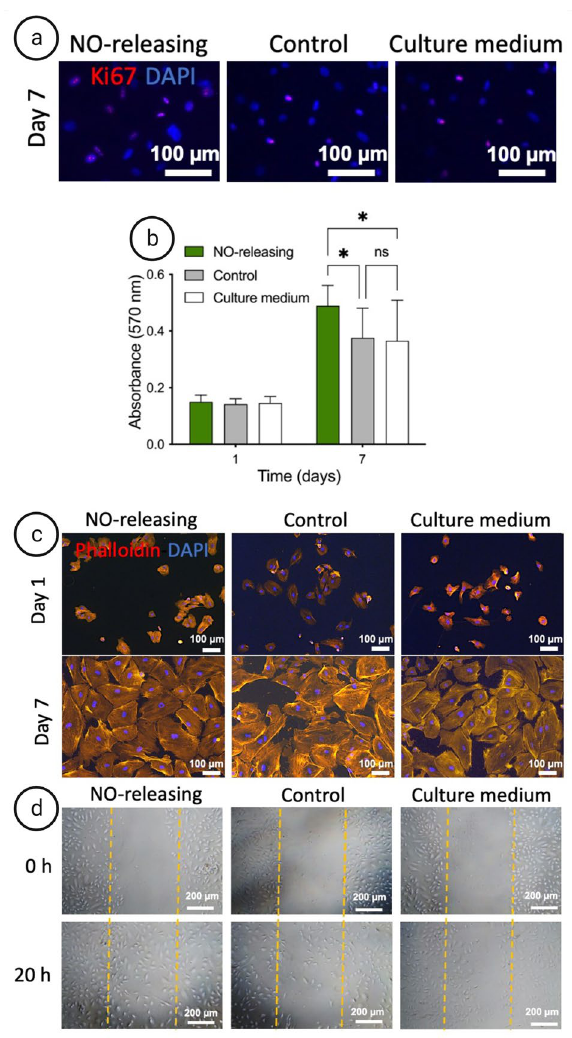
Figure 6. Evaluation of the NO-releasing effect on HUVEC proliferation, morphology, and migration. ( a , b ) Proliferation. ( a ) Immunofluorescence Ki67 staining (pink) and nucleus DAPI staining (blue) ECs incubated with NO releasing graft, control graft and culture medium after 7 days. ( b ) The obtained absorbances by MTT assay indicated a significant increase in the proliferation of HUVECs in response to NO-releasing samples while the proliferation rate was not significantly different in the presence of control samples or culture medium. ( c ) Morphology. Immunofluorescent imaging of HUVECs after 1 and 7 days of cultivation in direct contact with NO-releasing grafts, control grafts and culture medium. F-actin was stained in red (phalloidin) and nuclei were stained in blue (DAPI). ( d ) Migration. Scratch assay of HUVECs in presence of NO-releasing graft, control graft and culture medium. The monolayer of HUVECs was scratched with a 1000 µL pipette tip indicating orange dots at the beginning of the experiment (upper row) and after 20 h (lower row) of incubation. Data are shown as mean ± SD (n = 6). *P <